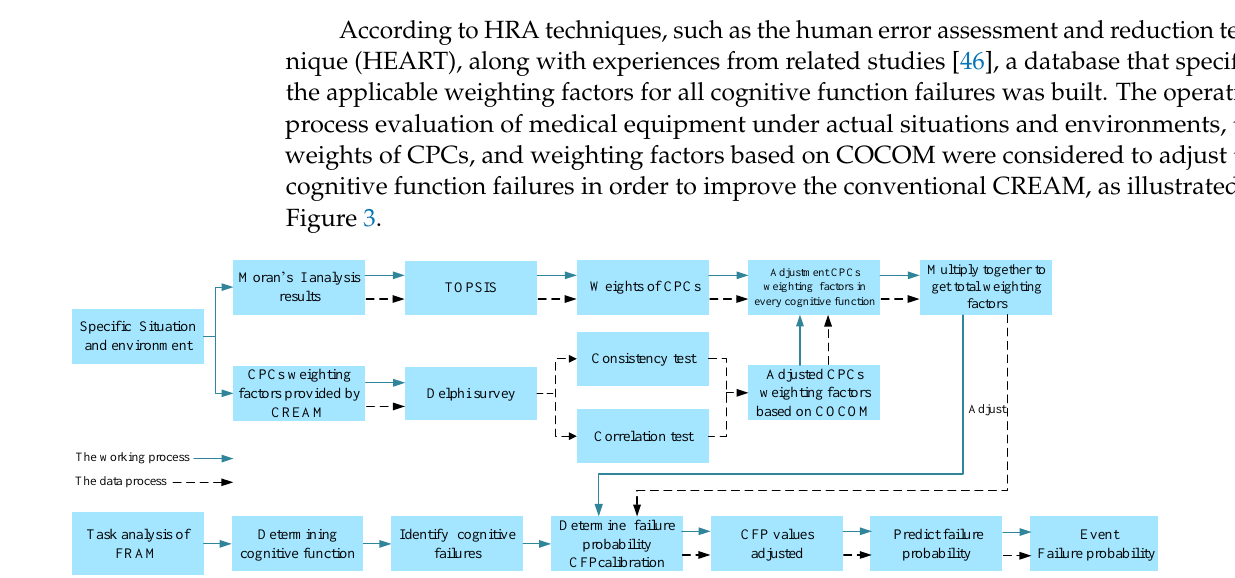
Figure 2. The relationships of CPCs and COCOM functions.